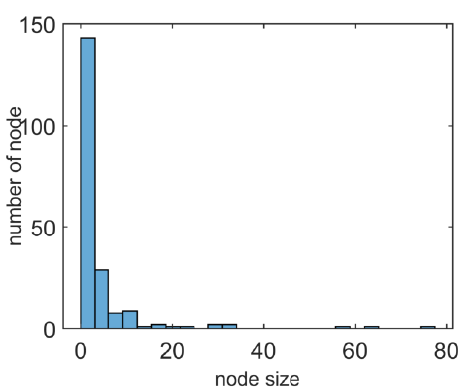
Figure 12. Probability density function of power-law